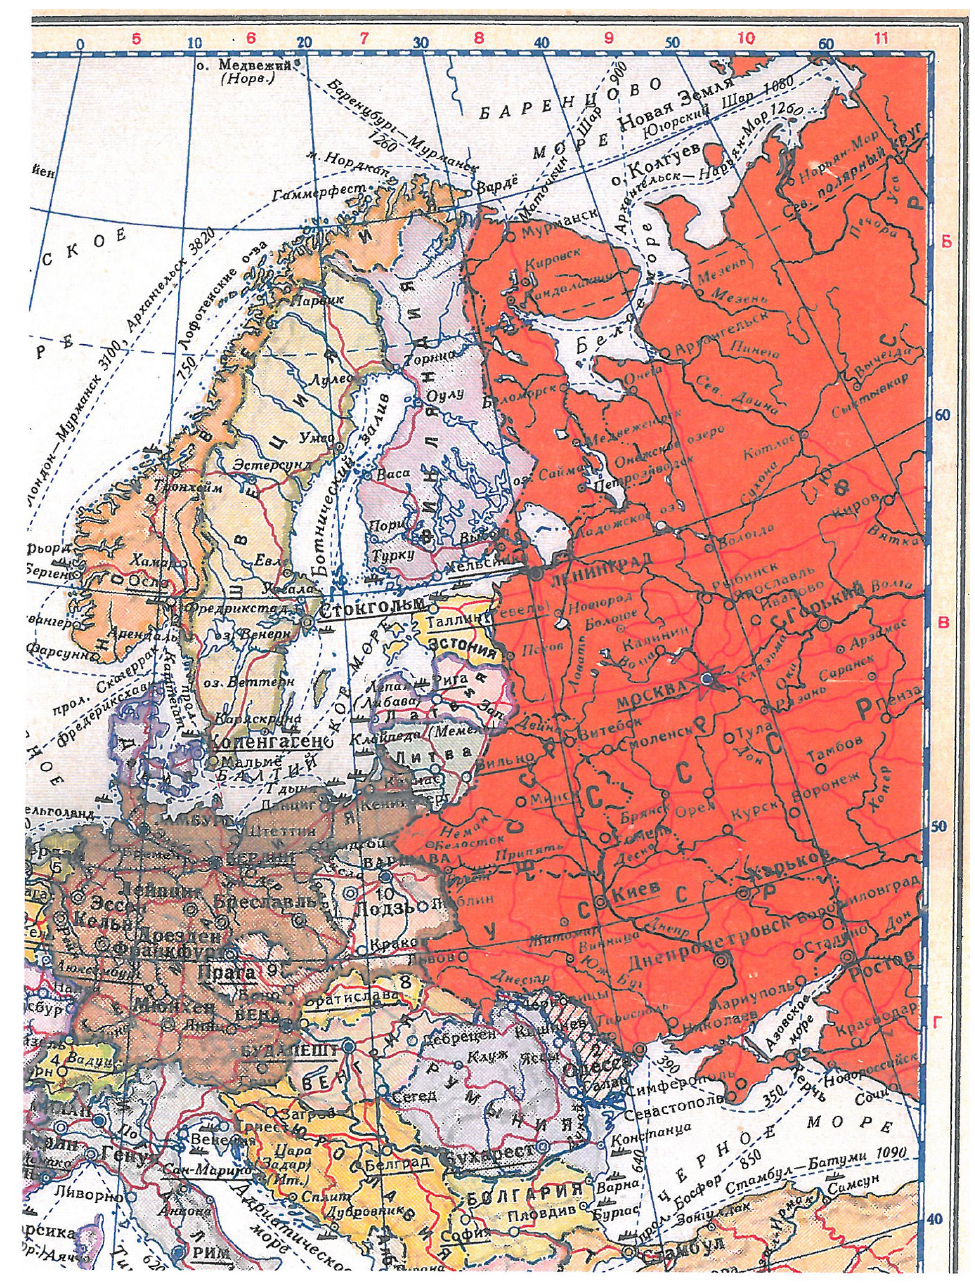
Fig. 1. Political divisions of Europe in 1940 (part of the